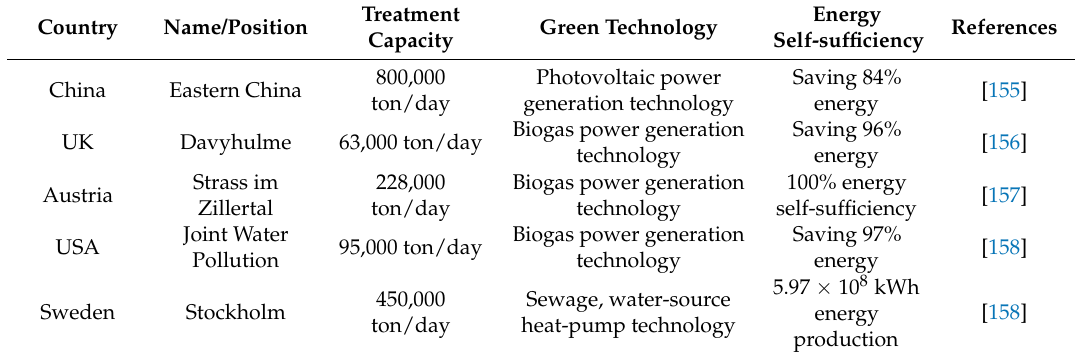
Table 4. Practical implementation of green technology in